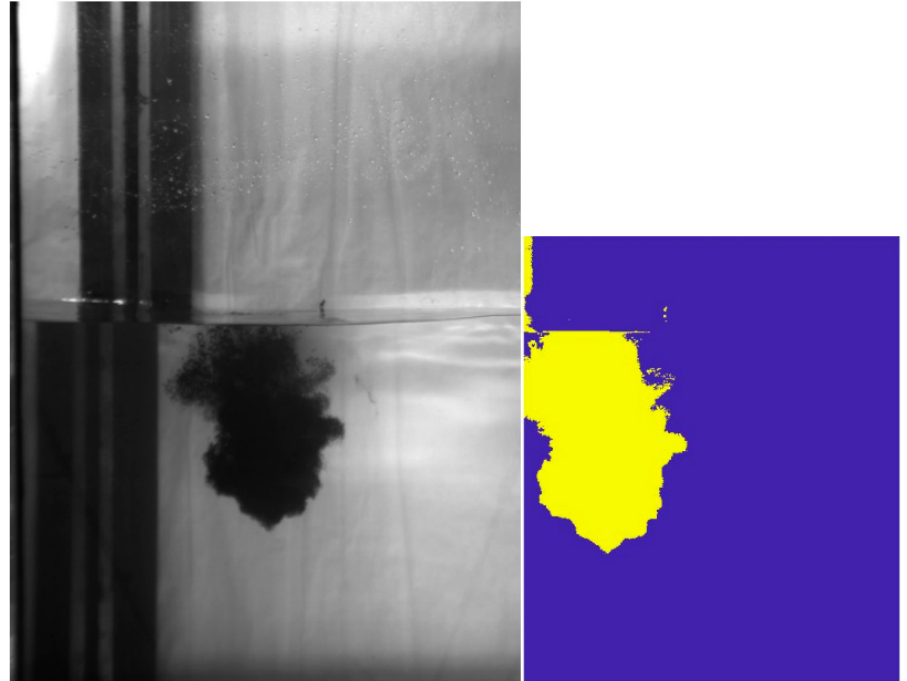
Figure 4. Spilled oil in the observation area without breaking wave.